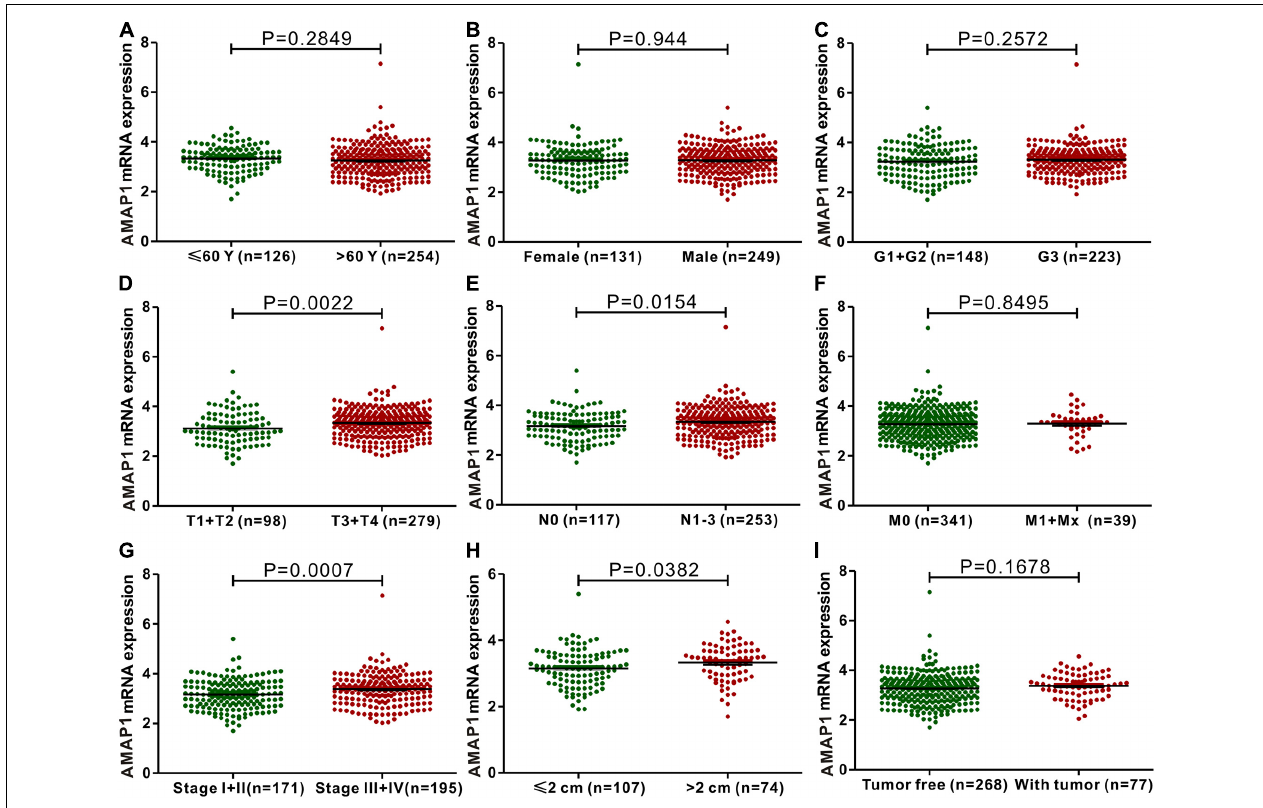
FIGURE 3 | Association between AMAP1mRNA based on TCGA-STAD dataset and clinical characteristics, including age (A) , gender (B) , G stage (C) , T stage (D) , N stage (E) , M stage (F) , TNM stage (G) , tumor size (H) , and cancer status (I)